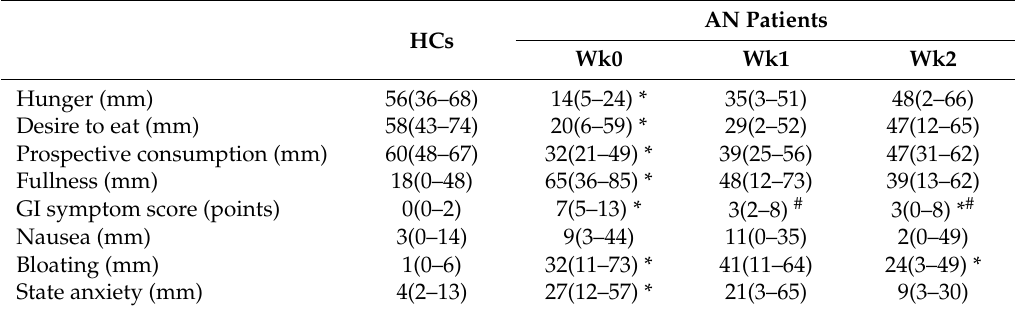
Table 1. Appetite perceptions, GI symptoms and state anxiety at baseline 1